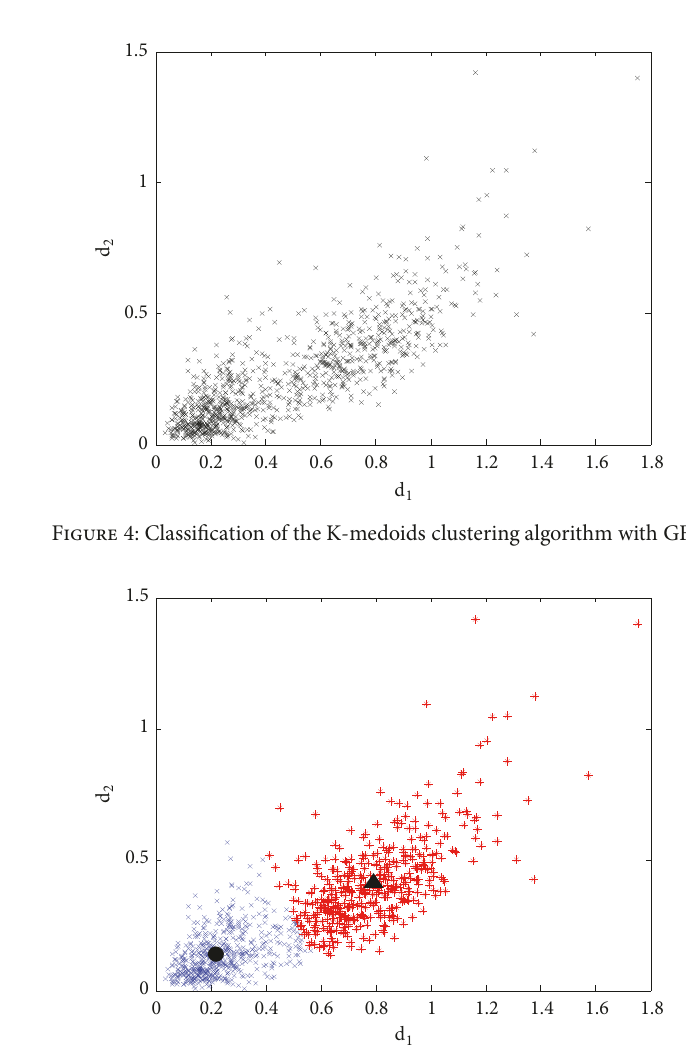
Algorithm 1: The overall process of EMDIGK.